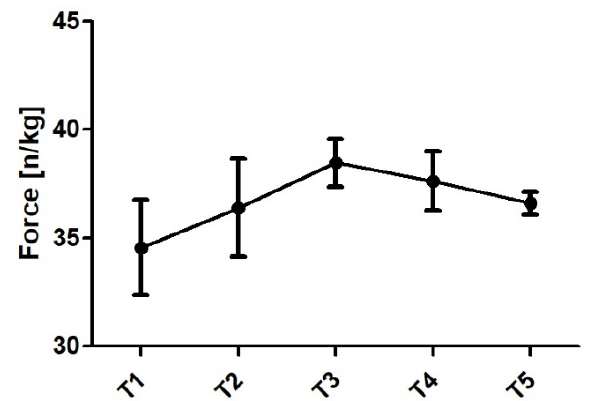
Figure 1. Peak force from the IMTP test. Table 10. Relative peak force data [N · kg − 1 ]. Mean ( ± SD).